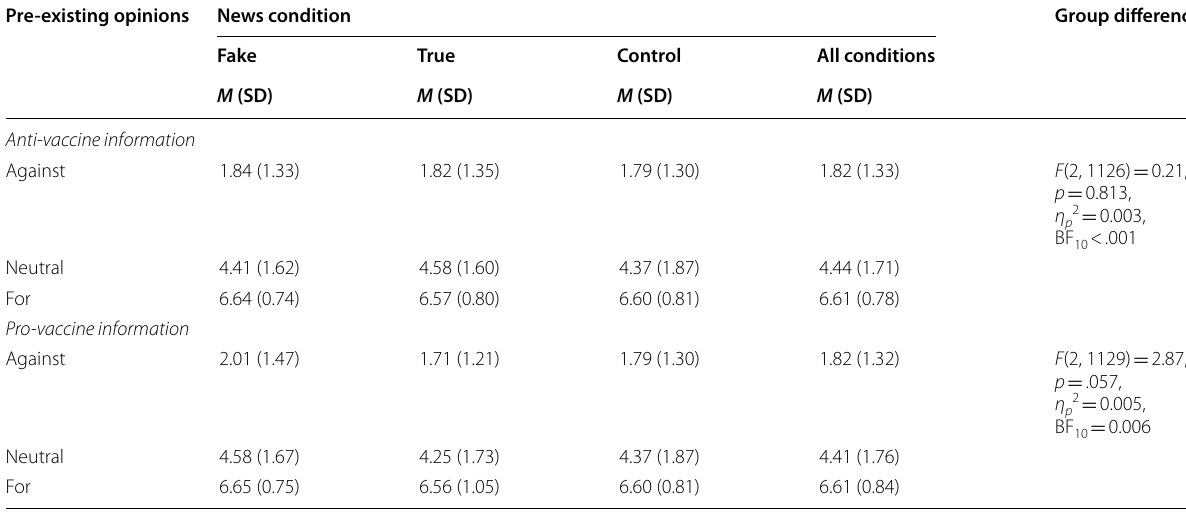
Table 2 Effects of true and false pro- and anti-vaccine information exposure on vaccination intentions in Study 1 and Study 2, controlling for pre-existing vaccine opinions